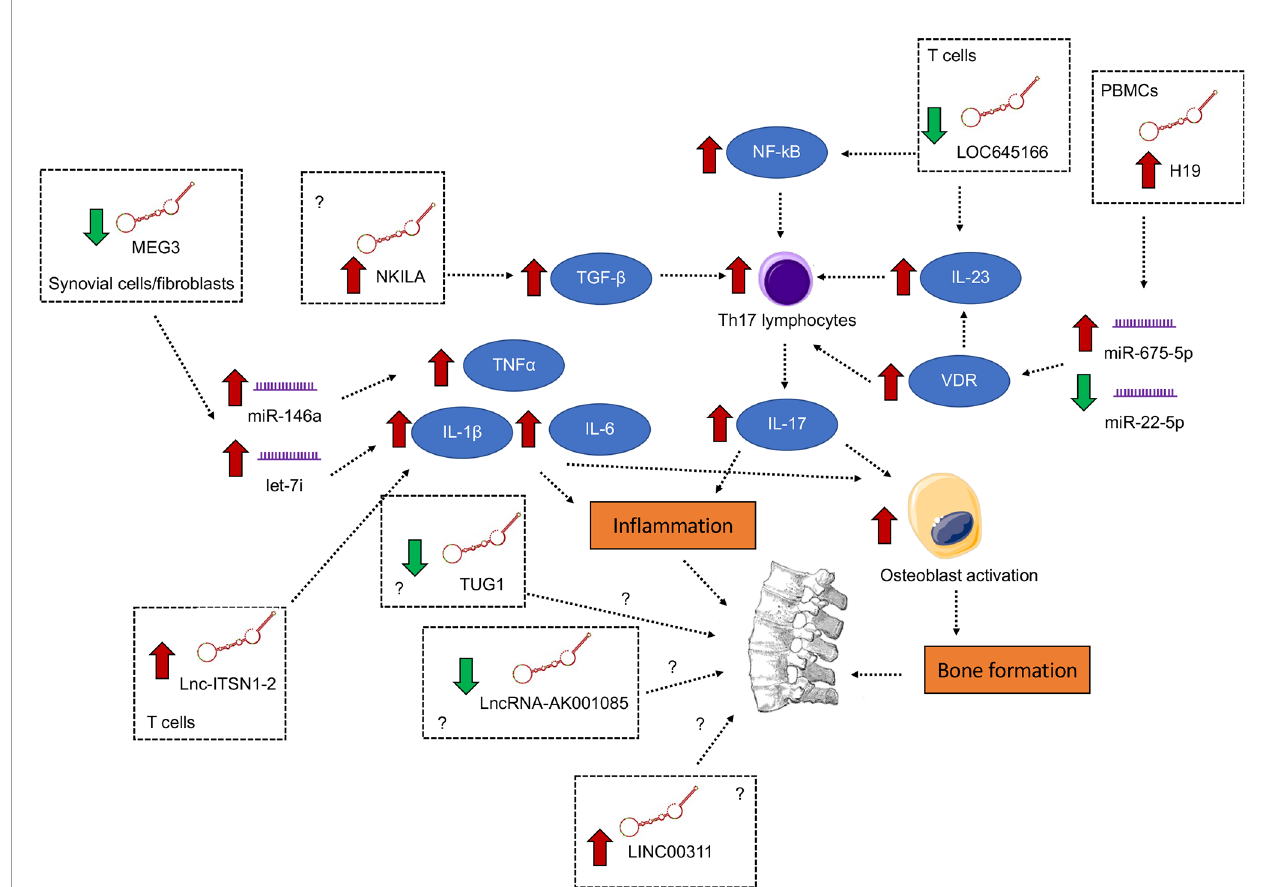
FIGURE 1 | Differentially expressed lncRNAs with functional importance in the pathogenesis of ankylosing spondylitis. The signaling converge on the induction of pro-in fl ammatory cytokines IL-1 b , TNF- a and IL-6 and the augmentation of the IL-23/IL-17 axis, both of which contribute to in fl ammation and abnormal bone